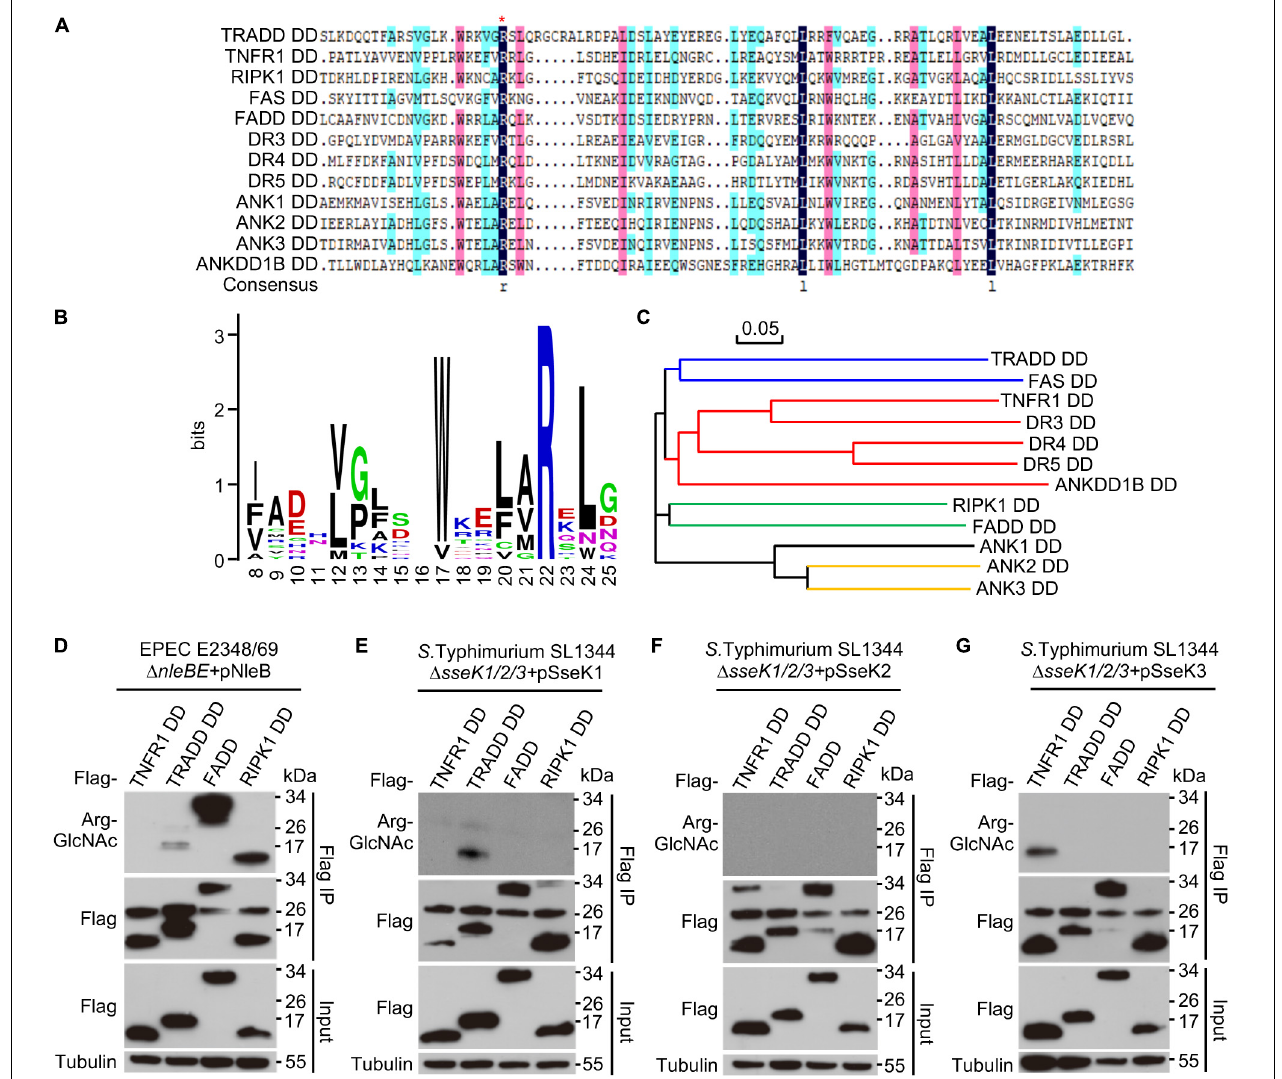
FIGURE 1 | SseK1 and SseK3 selectively modify TRADD and TNFR1 during pathogen infection. (A) Multiple sequence alignment of 12 DD proteins from 34 human DD-containing proteins. The red asterisk indicates the conserved arginine. (B) Site distribution of amino acids in 12 conserved arginine containing-DDs. (C) Phylogenetic tree of the 12 DDs constructed on the basis of sequence similarity. (D–G) Selective GlcNAcylation of DDs by NleB and SseK1/2/3 during bacterial infection. 293T cells transfected with the indicated Flag-DD plasmids were infected with EPEC or Salmonella strains. Cell lysates were subjected to anti-Flag immunoprecipitation and immunoblotting. Data in (D–G) are from at least three independent experiments.